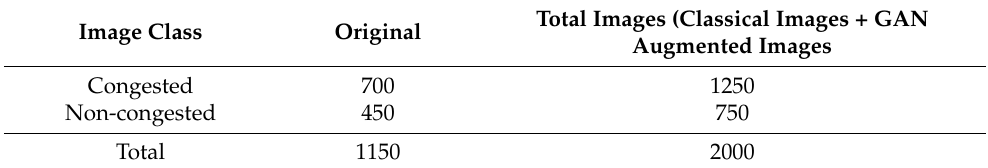
Table 1. The numbers of images in the dataset before and after the process of augmentation.